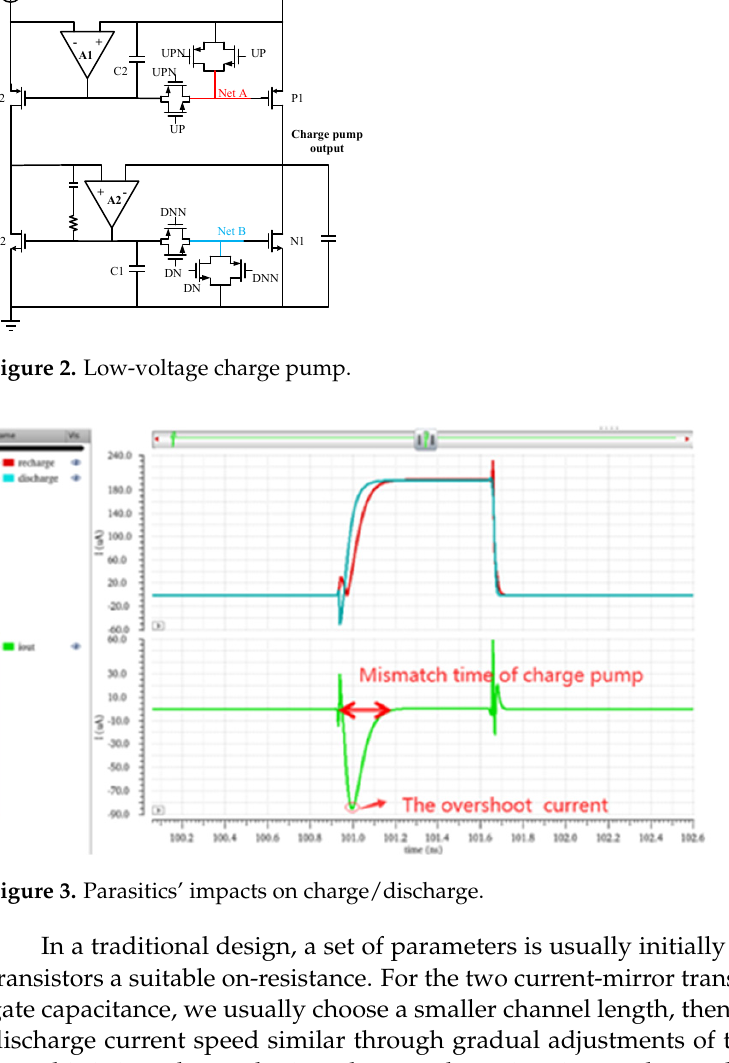
Figure 2. Low-voltage charge pump.